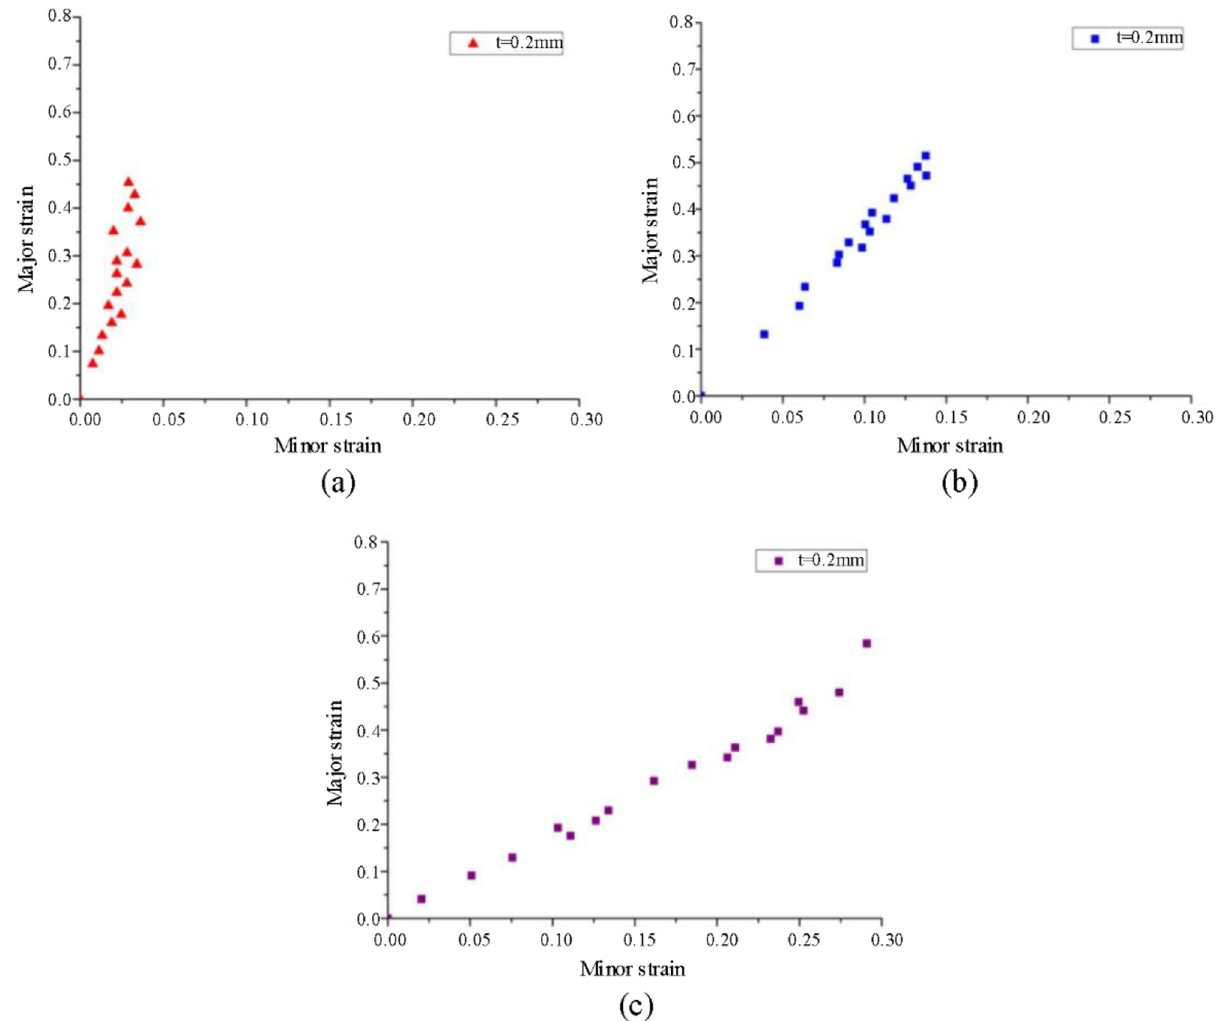
Fig. 9. Bulging-forming limit strain of different specimens without ultrasonic vibration. (a) spec1. (b) spec2. (c)